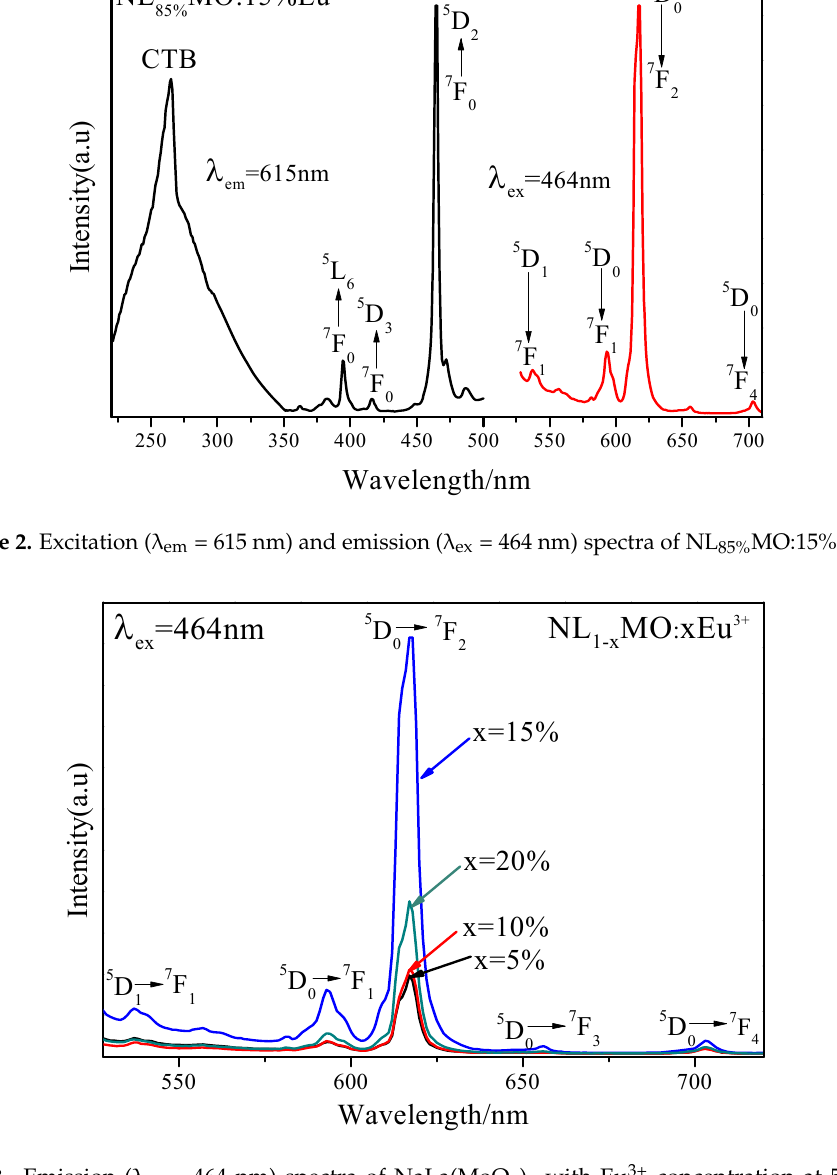
Figure 3. Emission ( λ ex = 464 nm) spectra of NaLa(MoO 4 ) 2 with Eu 3+ concentration at 5, 10, 15 and 20 mol %.